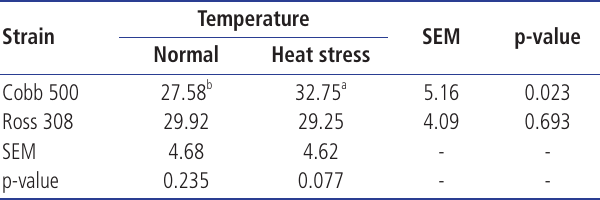
Table 4. Creatine kinase (mmol/L) when the interactions between strain and temperature were significant Temperature Strain